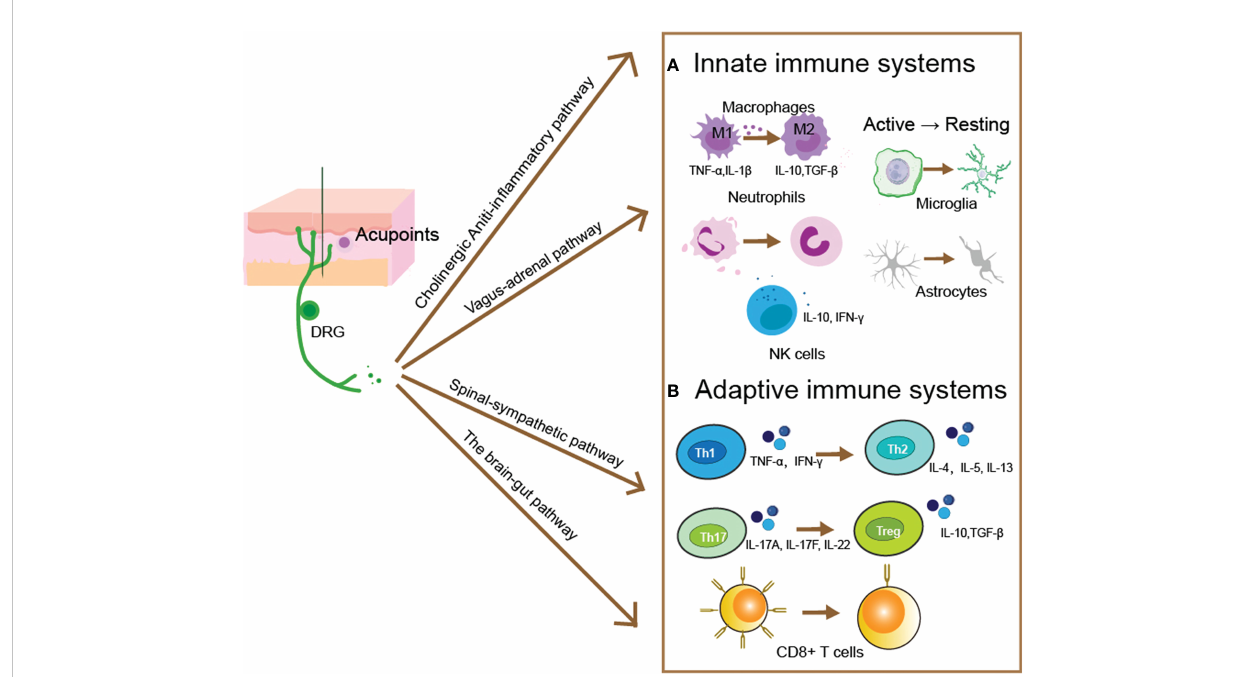
FIGURE 1 Acupuncture evoked pathways for modulating innate and adaptive immune responses. After acupuncture evoked a mechanical and thermal stimulus within acupoints, the generated electrical signal then transmitted by somatic sensory fi bers to the central nervous system, and produced distinct descending regulatory pathways. Such as the cholinergic anti-in fl ammatory pathway, the vagal-adrenal pathway, the spinal-sympathetic pathway, and the brain-gut pathway. These pathways then to restoring the immune homeostasis by moderating innate (A) and adaptive (B)